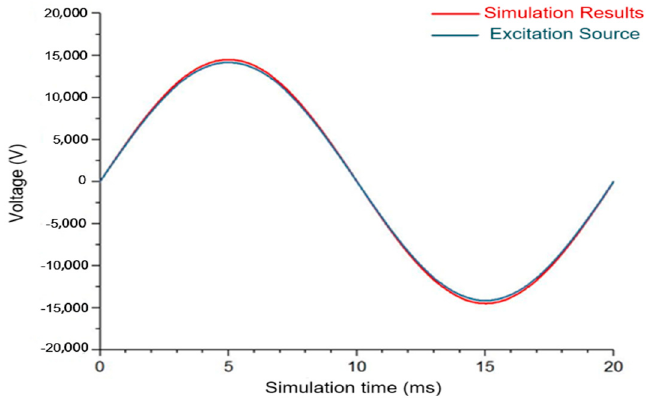
Figure 9. Calculating results of the node reconstruction method.